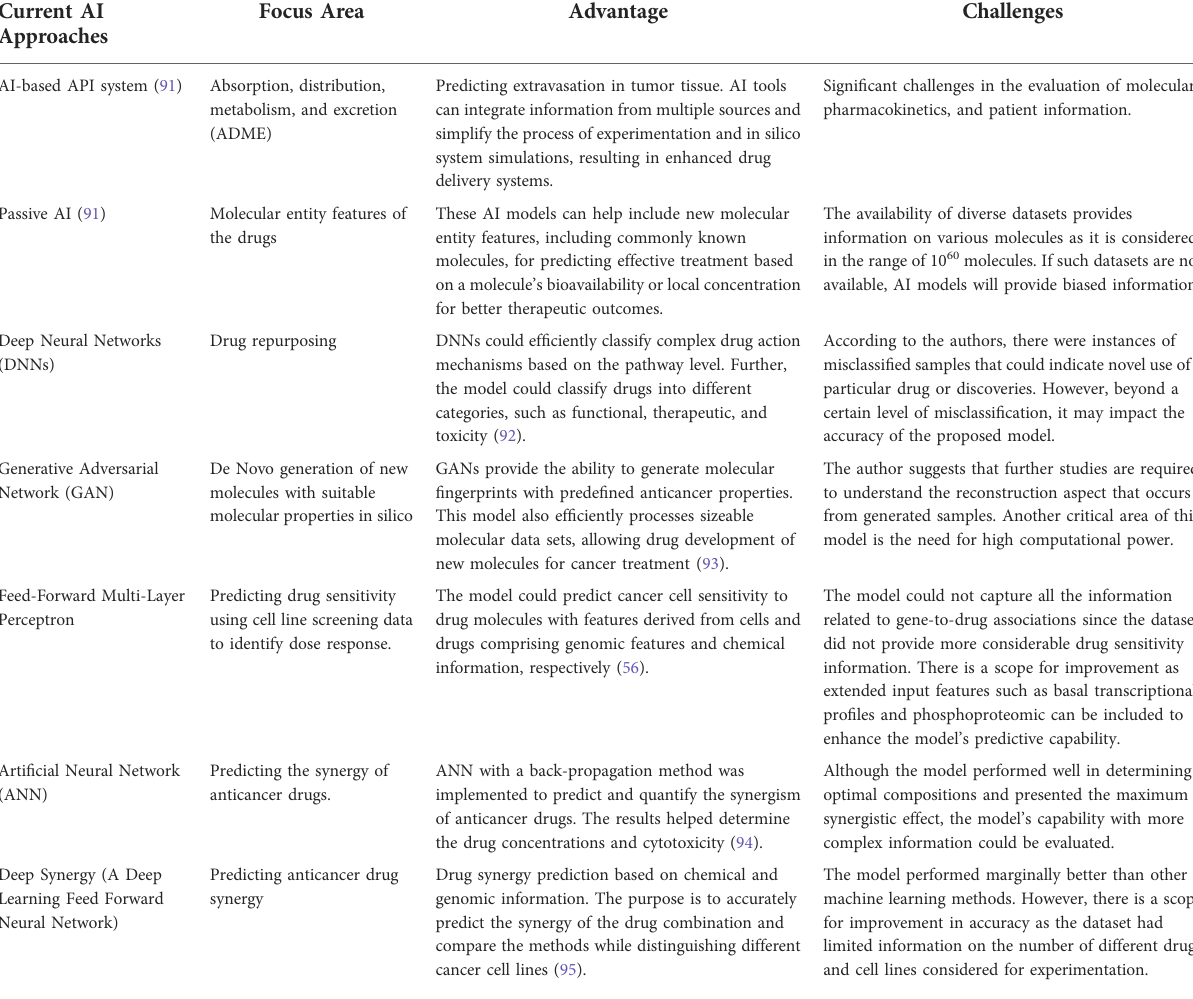
TABLE 1 Impact of AI in drug development